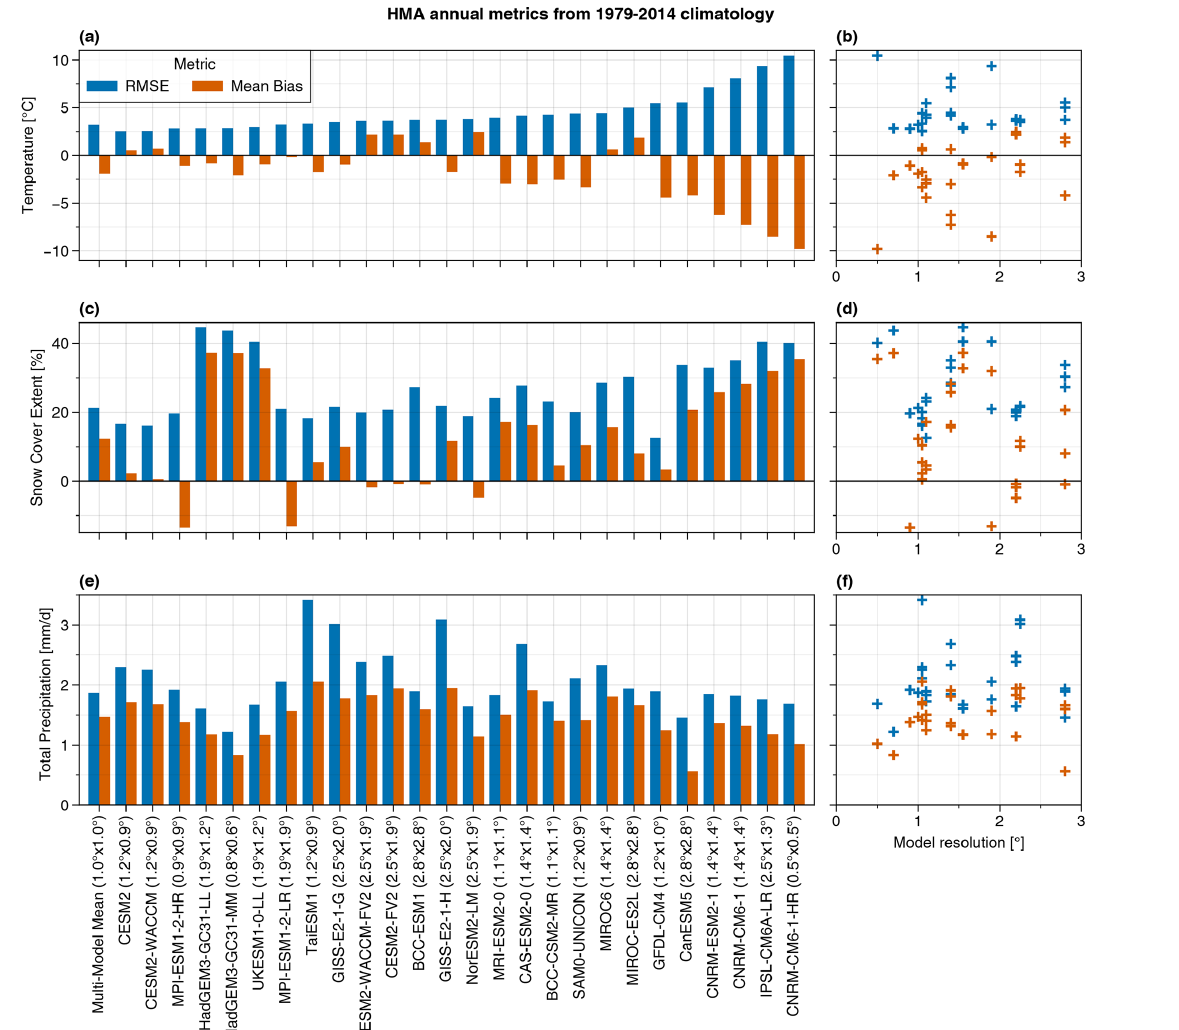
Figure 5. Annual spatial RMSE and bias computed over HMA with respect to CRU, NOAA CDR and APHRODITE, respectively, for temperature, snow cover and precipitation (a, c, e) . Models are ranked by increasing RMSE for temperature and the multimodel mean appears in the first histogram. The approximate original model’s resolution is given, but all metrics are computed on a common 1 ◦ × 1 ◦ grid after interpolation. Panels (b, d, f) are similar to (a, c, e) with models ranked as a function of their original mean lat/long resolution. Blue and red crosses correspond respectively to RMSE and mean